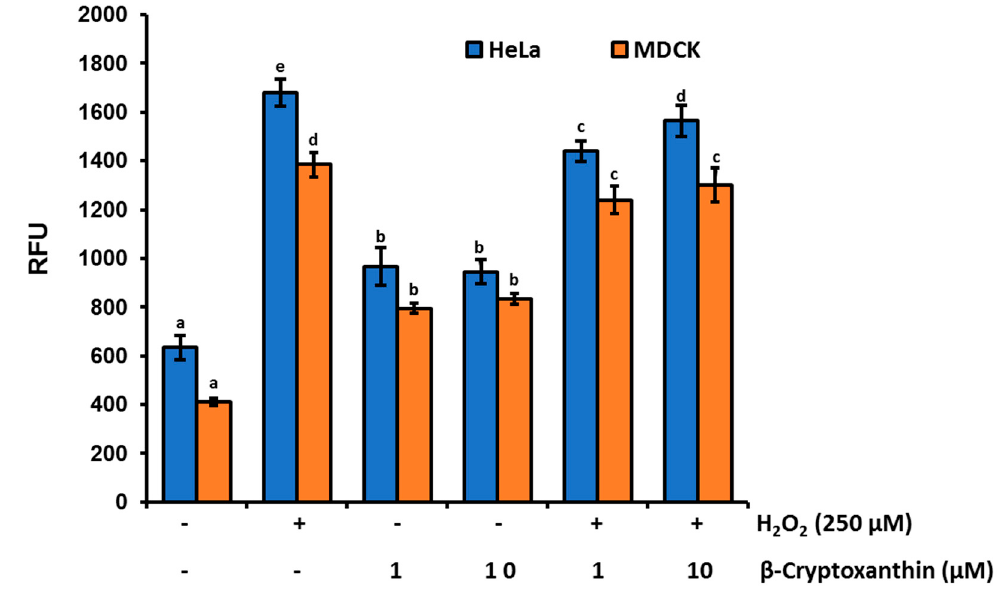
Figure 3. The effect of β -cryptoxanthin treatments on cellular ROS productions and accumulations. The enhanced levels of cellular ROS in both normal MDCK and HeLa cells were triggered by treatments with 250 µM H 2 O 2 , followed by treatment with β -cryptoxanthin (1.0 and 10 µM) for 24 h. Relative fluorescence of ROS was assessed by a microplate spectrofluorometer. All data are reported as mean values ± SD from independent experiments ( n = 3). The means accompanied by different alphabets (e.g., a, b, c, d, and e) are significantly different at p < 0.05.